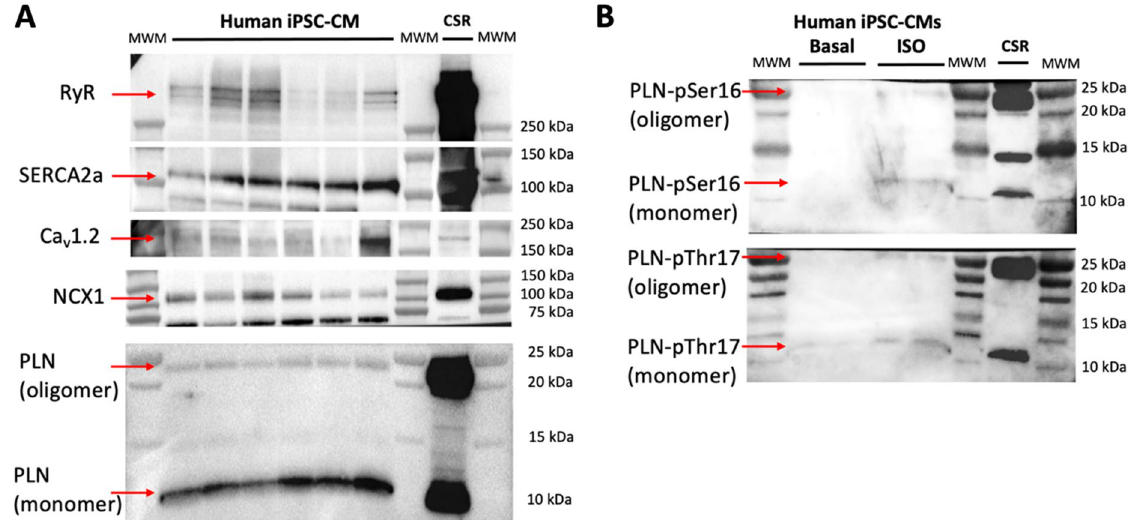
Figure 5. Expression of major Ca 2+ handling proteins in human iPSC-derived cardiomyocytes by western blot analysis. ( A ) Western blot analysis of human cardiomyocytes showed that these cells express all major proteins involved in Ca 2+ transport and regulation of the cardiac calcium pump SERCA2a. We analyzed the expression of the following proteins: RyR, ryanodine receptor; SERCA2a, the cardiac isoform of sarcoplasmic reticulum Ca 2+ -ATPase; Ca v 1.2, voltage-dependent L-type Ca 2+ channel, α-1C subunit; NCX1, Na + –Ca 2+ exchanger; PLN, phospholamban. ( B ) Detection of phosphorylated phospholamban (PLN) at positions Ser16 (PLN-pSer16) and Thr17 (PLN-pThr17) in response to pharmacological β2-adrenergic stimulation with isoproterenol (ISO, 1 µM); untreated cells were included in the analysis (basal, negative control). In all cases, we used a pig heart membrane preparation as a control (‘CSR’ lane) for the expression of Ca 2+ handling proteins tested in this